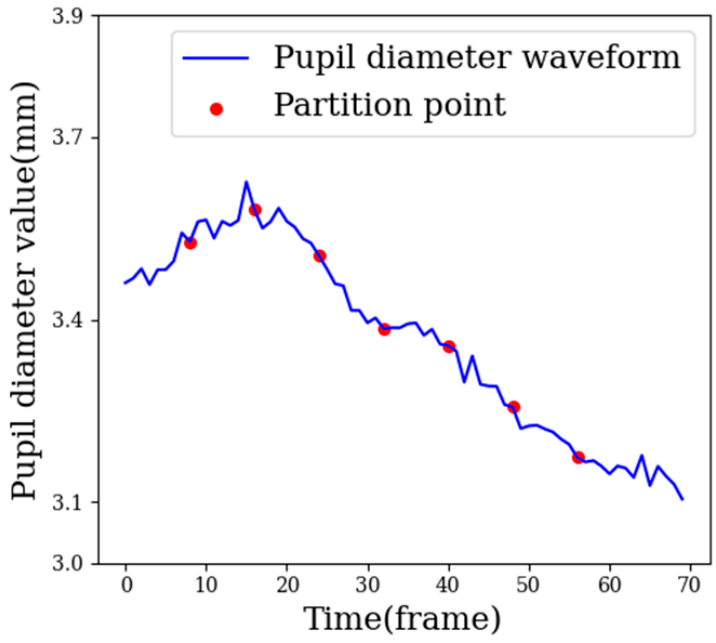
Figure 7. Fine-grained partition of adaptive samples.